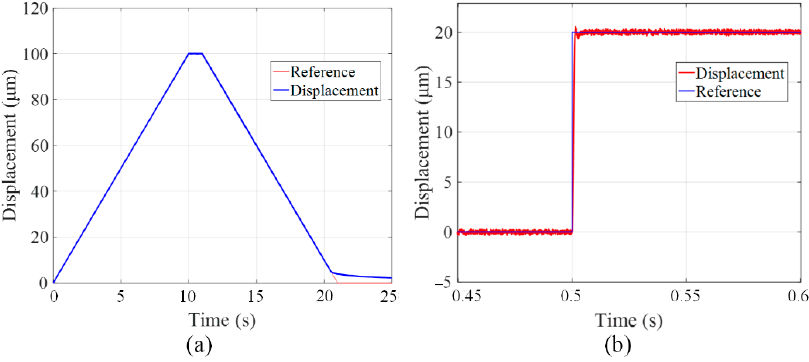
Figure 8. ( a ) The trapezoid response and ( b ) step response of the microgripper under close-loop control.